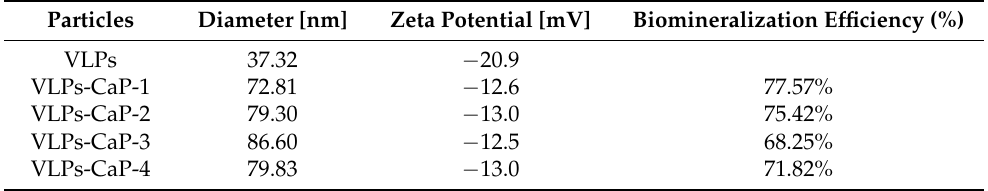
Table 1. Basic characterization of the VLPs-CaP